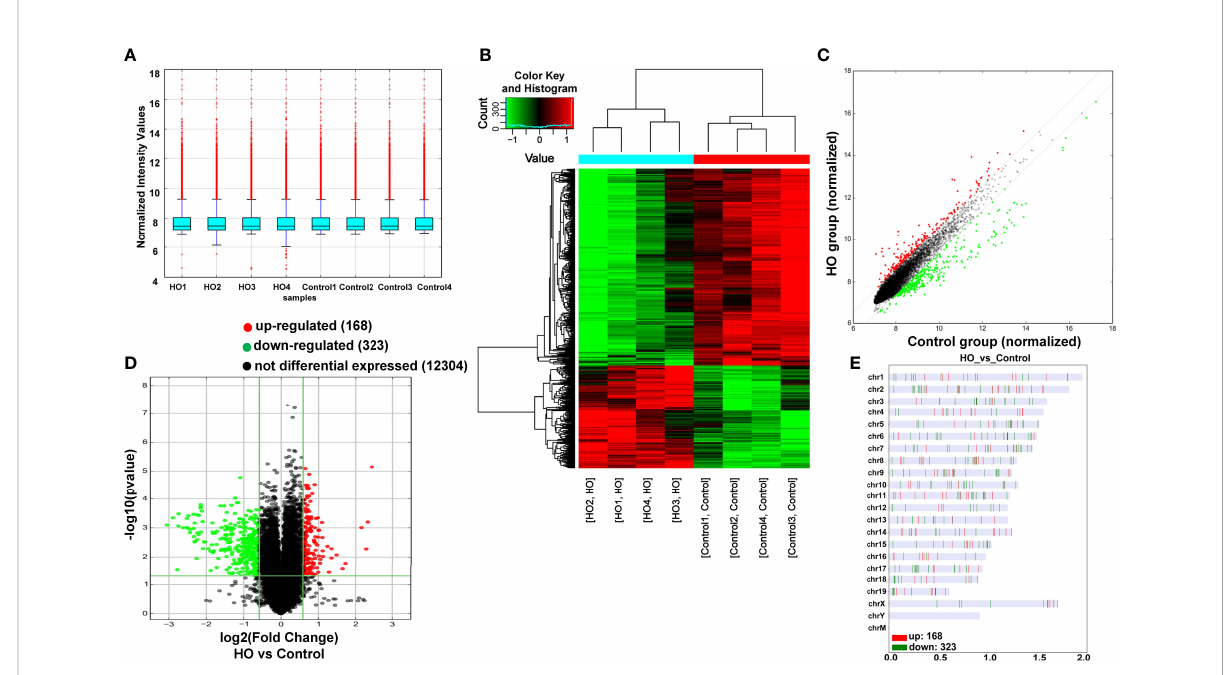
FIGURE 3 Differentially expressed pro fi le of circRNAs between HO and control samples. (A) The box plot shows the distribution of circRNAs between HO and control samples. (B) The Hierarchical clustering plot indicates the differentially expressed circRNA pro fi les in the eight samples. “ Red ” represents the higher expression, while “ green ” represents the lower expression level. (C) The scatter plot demonstrates the differentially expressed circRNA pro fi les in the eight samples. (D) The volcano plot exhibits the distinguishable circRNAs expressions. (E) Chromosomal distributions of circRNAs in HO and control